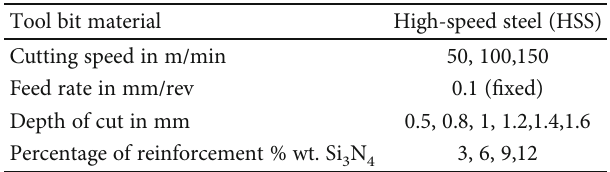
Table 3: Machining